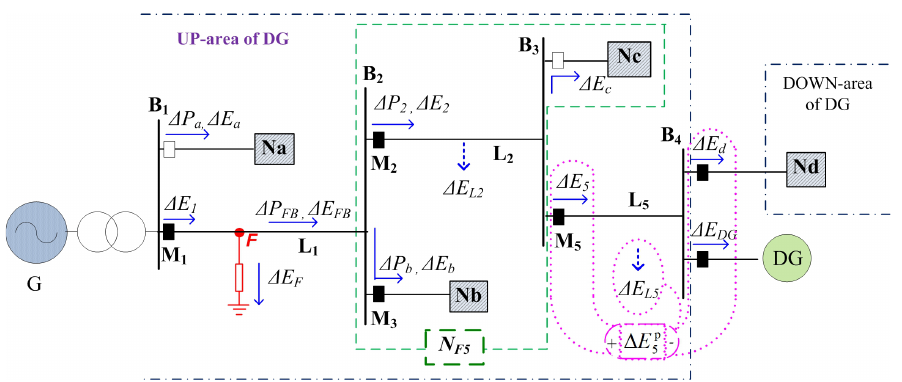
Figure 8. Scalable grid model with DG